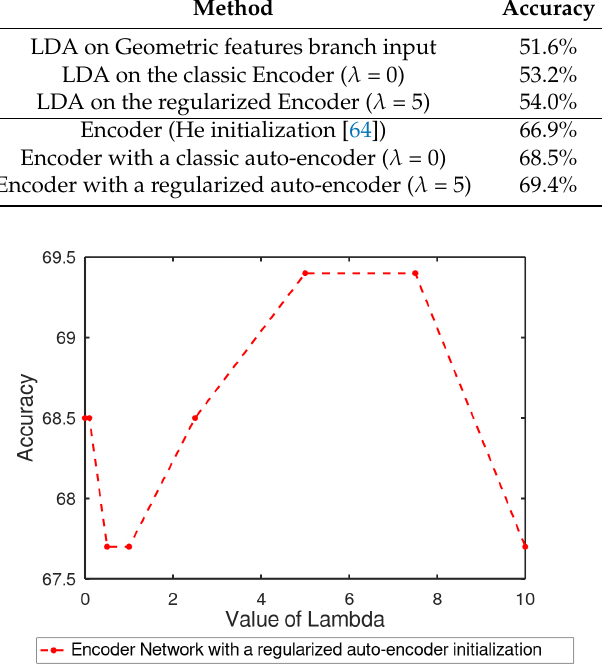
Figure 8. Intention prediction accuracy of the Geometric branch alone, as a function of its λ parameter. Table 2. Ablation studies: classification accuracy of the Cartesian branch for pedestrian intention prediction for the C/NC task in